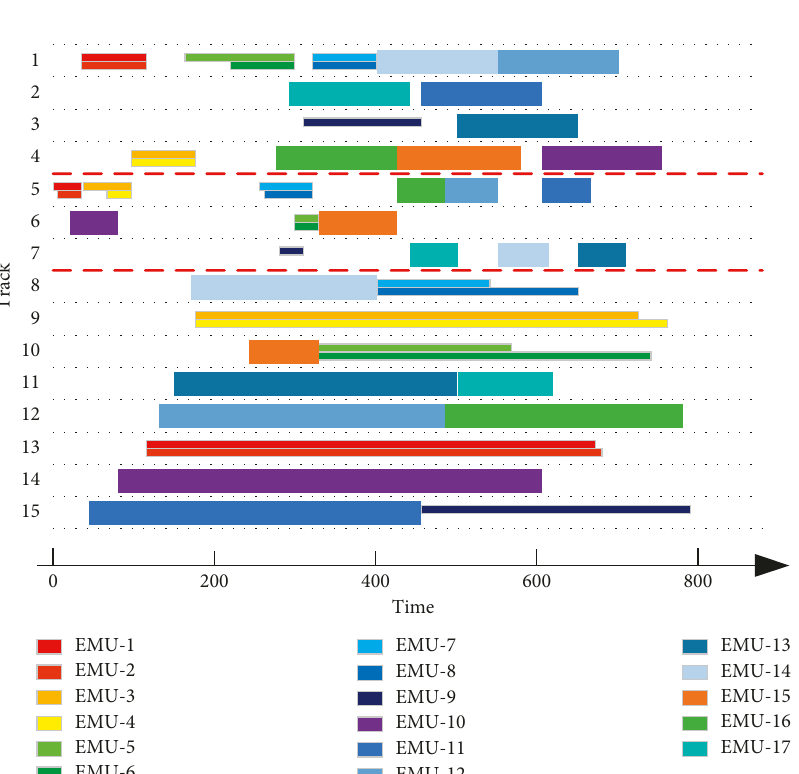
Figure 9: A Gantt chart representation for the optimized shunting plan at the through EMU depot generated by the RVNS